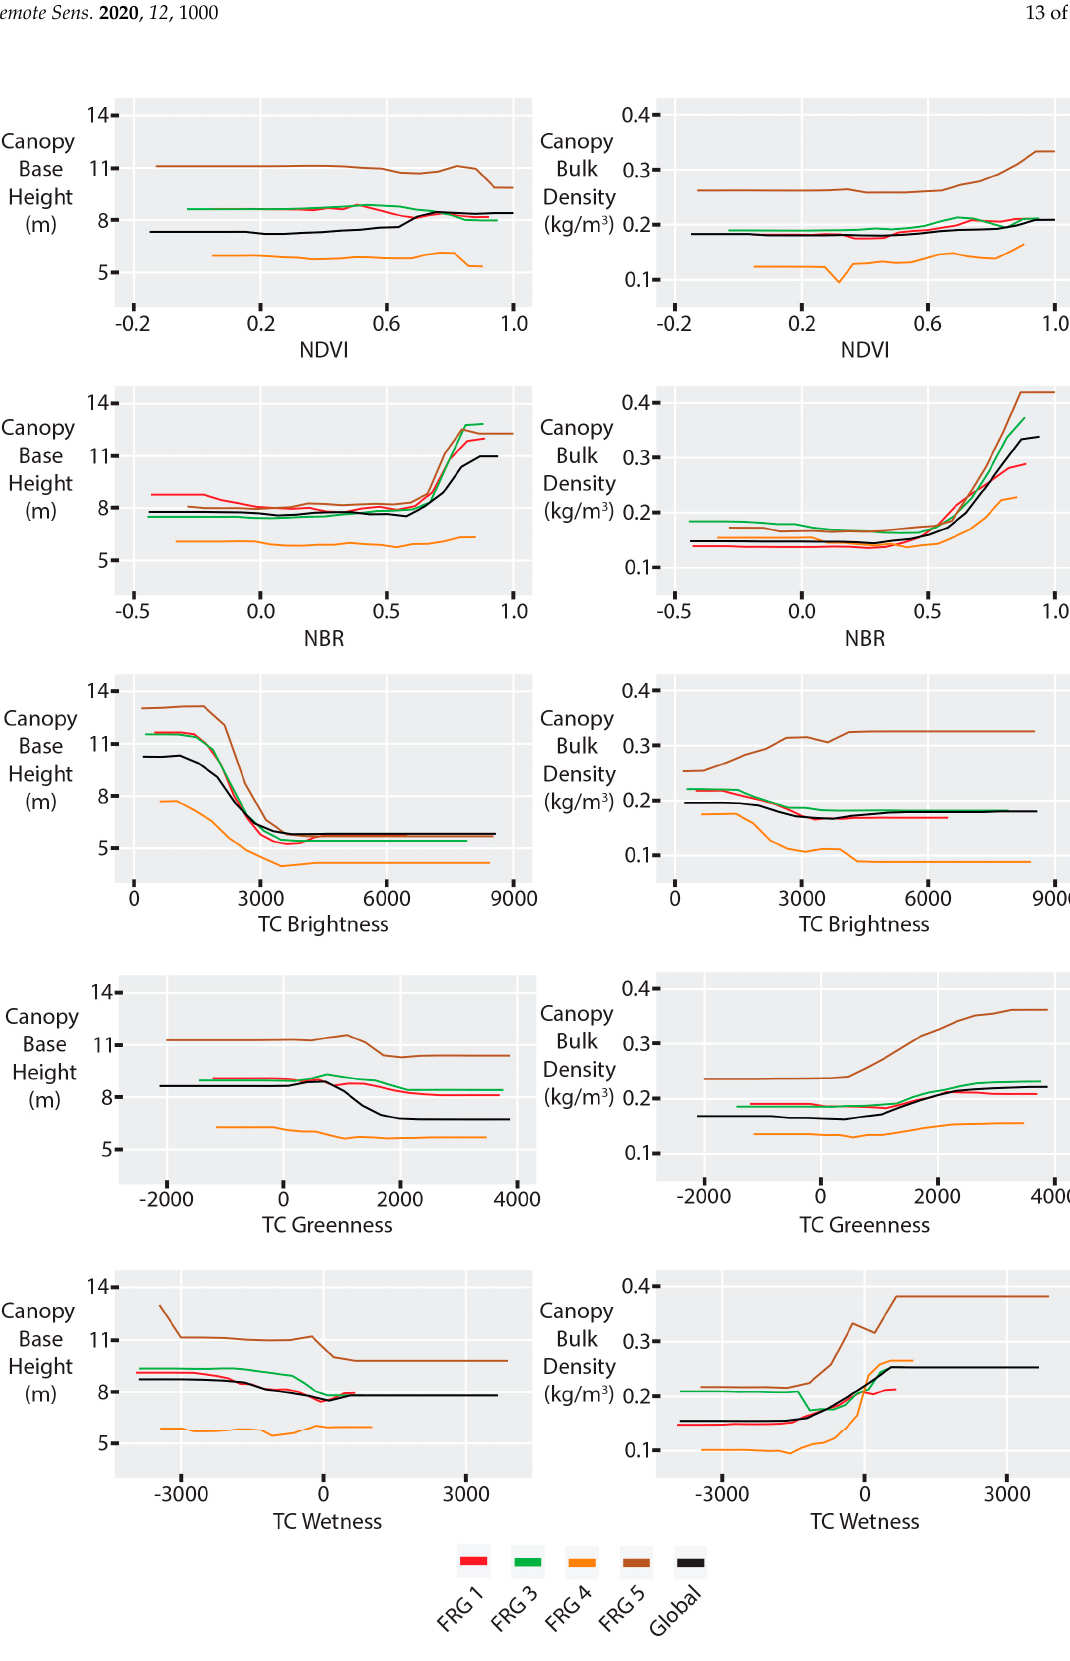
Figure 6. Partial dependence plots for each predictor variable ( x-axes ) and the canopy base height and canopy bulk density response variables ( y-axes ). Each line shows the partial dependence using the fire regime group ( FRG; colored ) and global ( black ) landscape datasets.